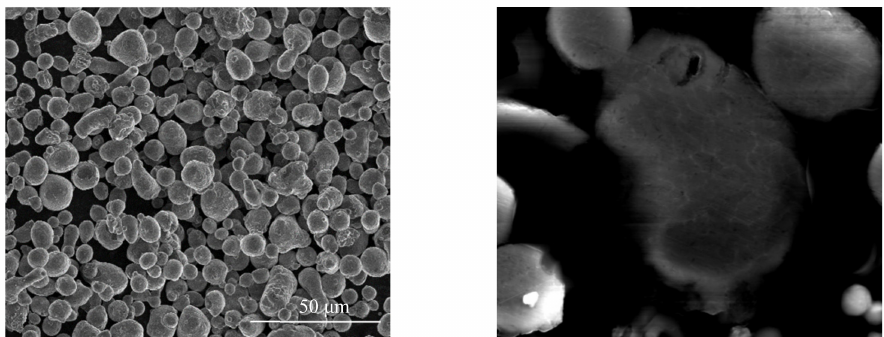
Figure 2. Images showing the shape and size of the raw Al7075 powders.